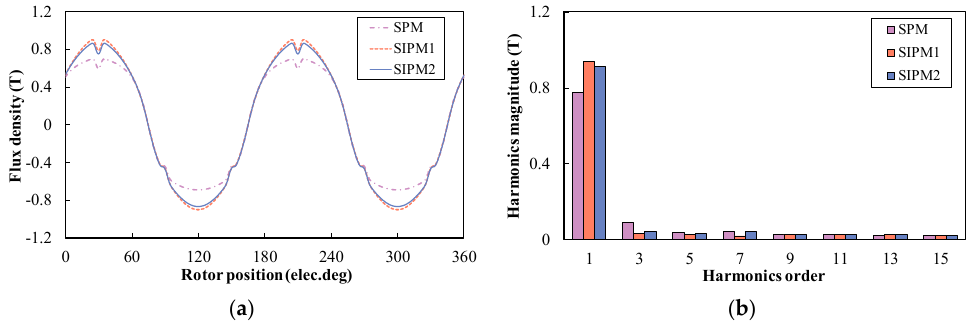
Figure 8. No-load airgap flux density. ( a ) Waveforms. ( b ) Harmonics order.